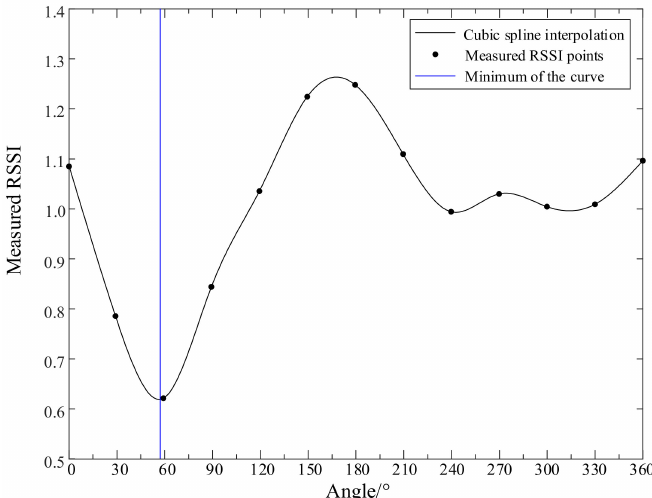
Figure 9. Diagram of cubic spline